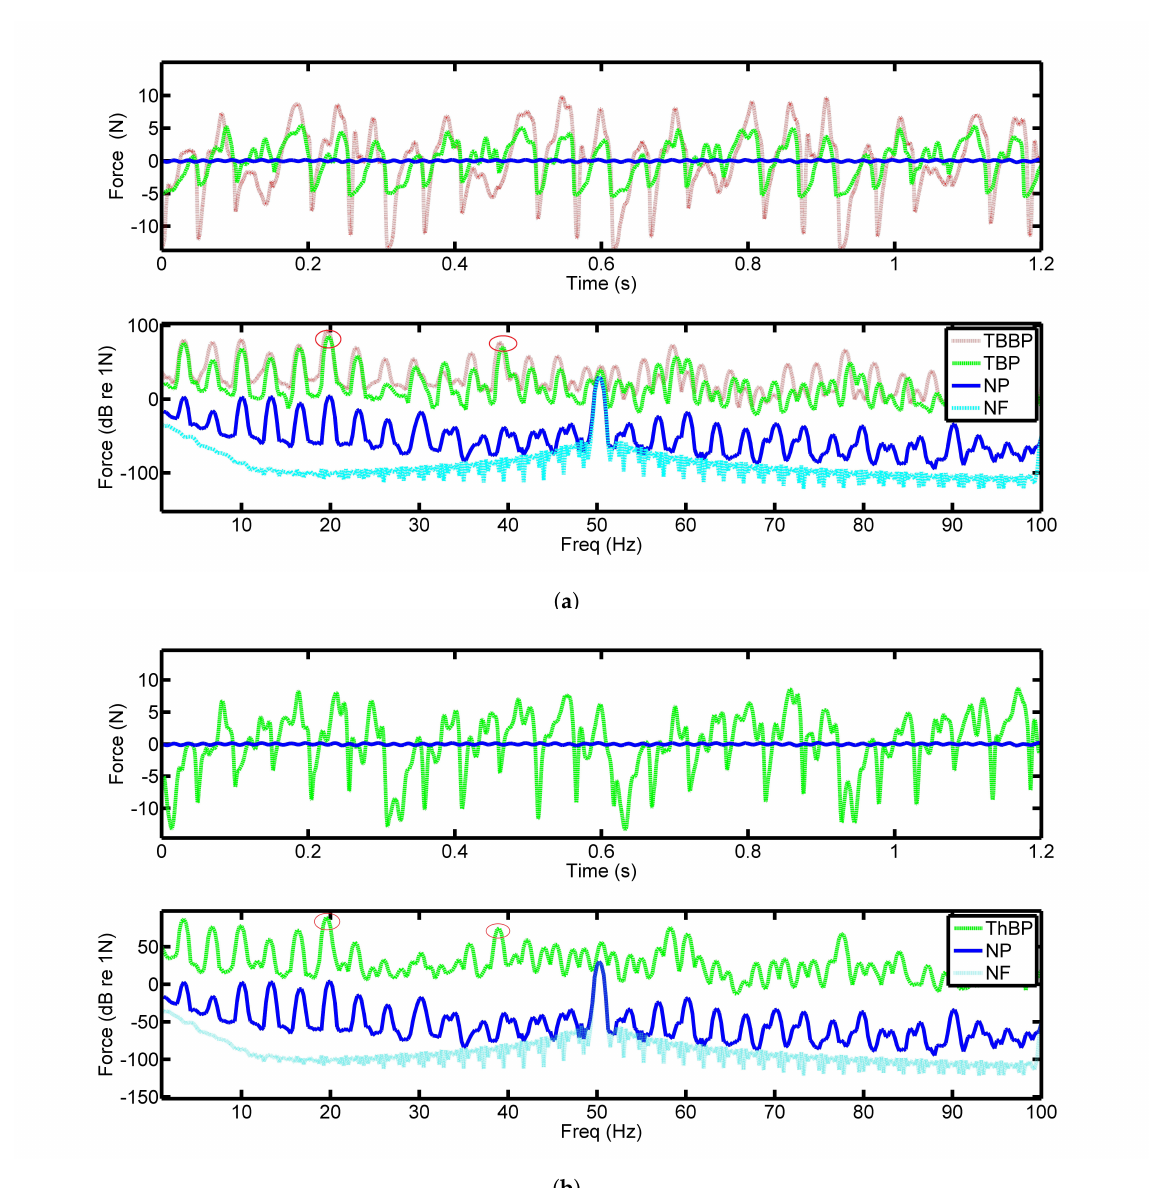
Figure 4. Captured force from the PVDF with the: ( a ) two-blade propeller, ( b ) three-blade propeller rotating at 200 RPM with a six-pad bearing, time (top) and frequency (bottom) data. Where: TBBP–Two-blade brass propeller, TBP–Two-blade propeller, ThBP - Three-blade propeller, NP–No propeller, NF–Noise